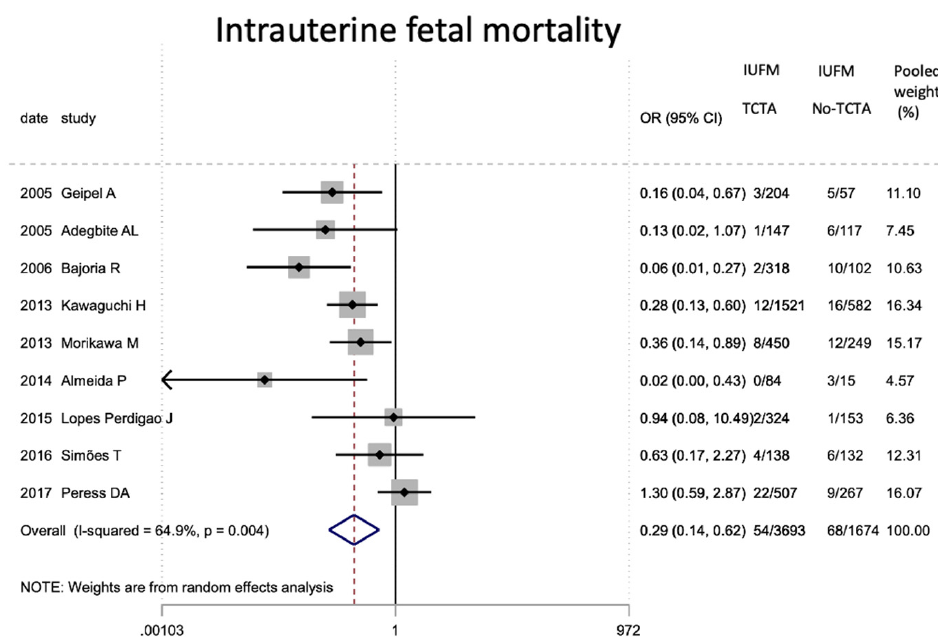
Figure 15. Results of the meta-analysis on the effect of chorionicity (TCTA vs no TCTA) on intrauterine fetal mortality. MFIU: intrau-terine fetal mortality; TCTA: trichorial-triamniotic, non-TCTA: non-trichorial-triamniotic. OR = odds ratio, CI = confidence interval.